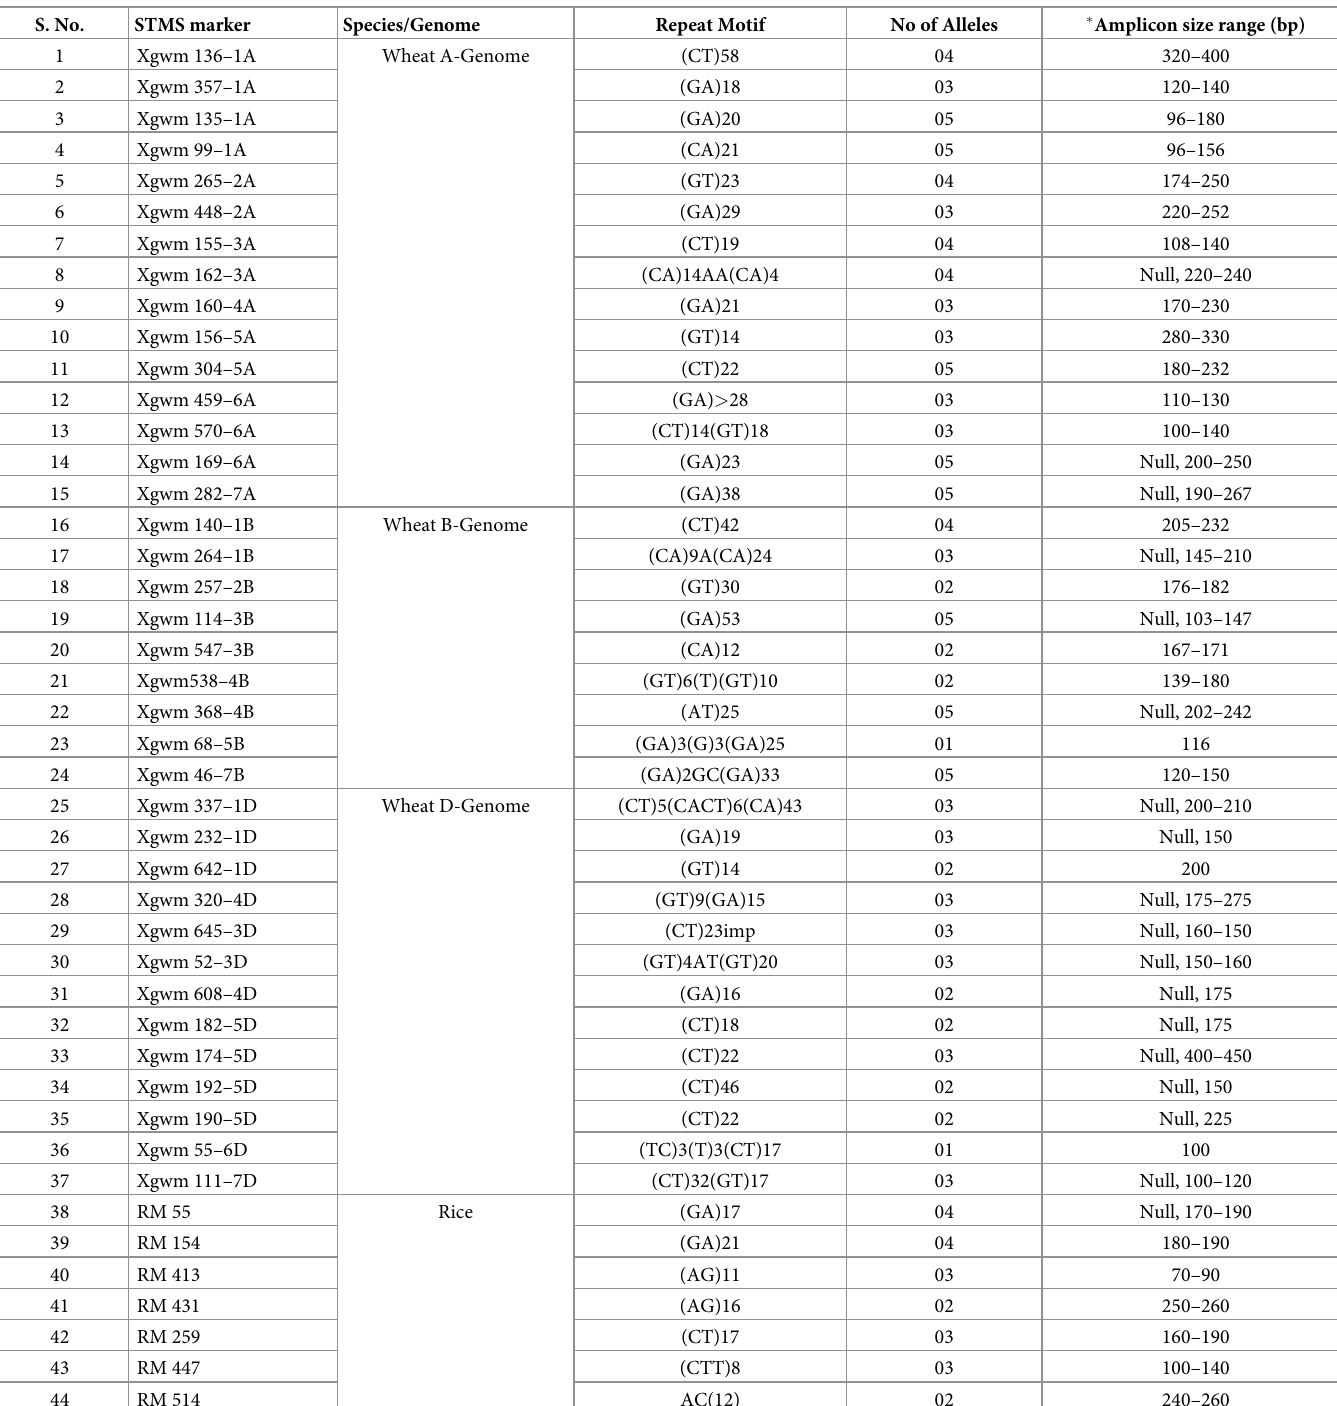
Table 2. List of wheat A, B, and D-genome, and rice STMS marker loci analyzed in the present study. S.